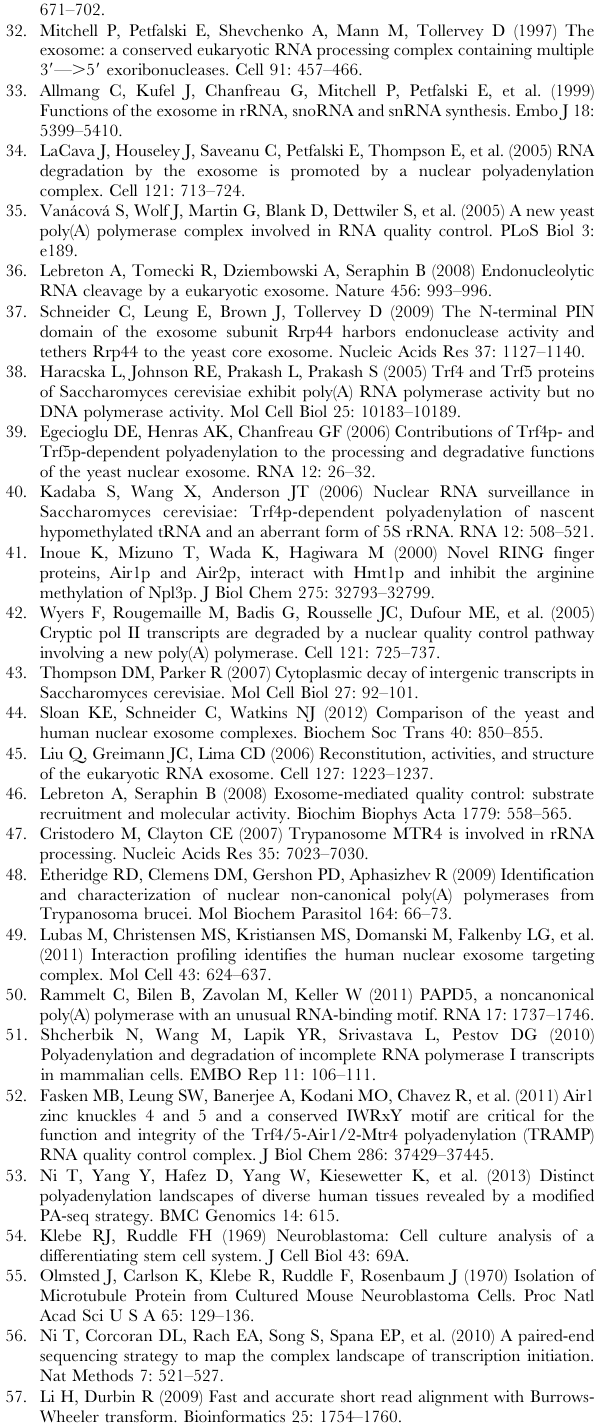
Table S4 All oligos used for qPCR.